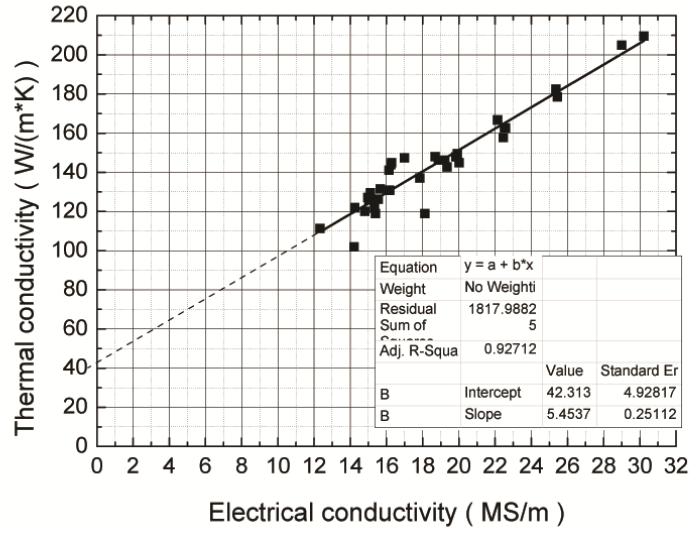
Figure 11. The relationship between electrical conductivity and thermal conductivity of the Al-Si- Cu alloys.